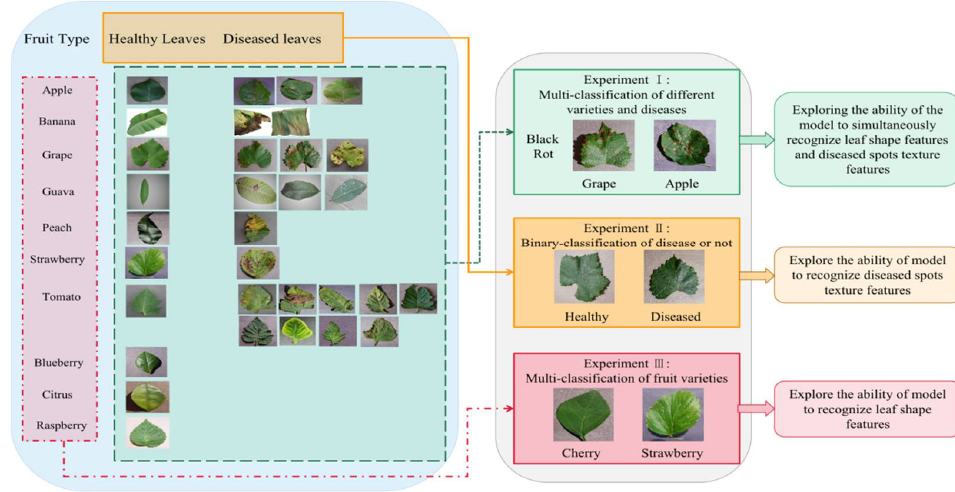
Figure 1. Dataset and schematic diagram of experimental design.